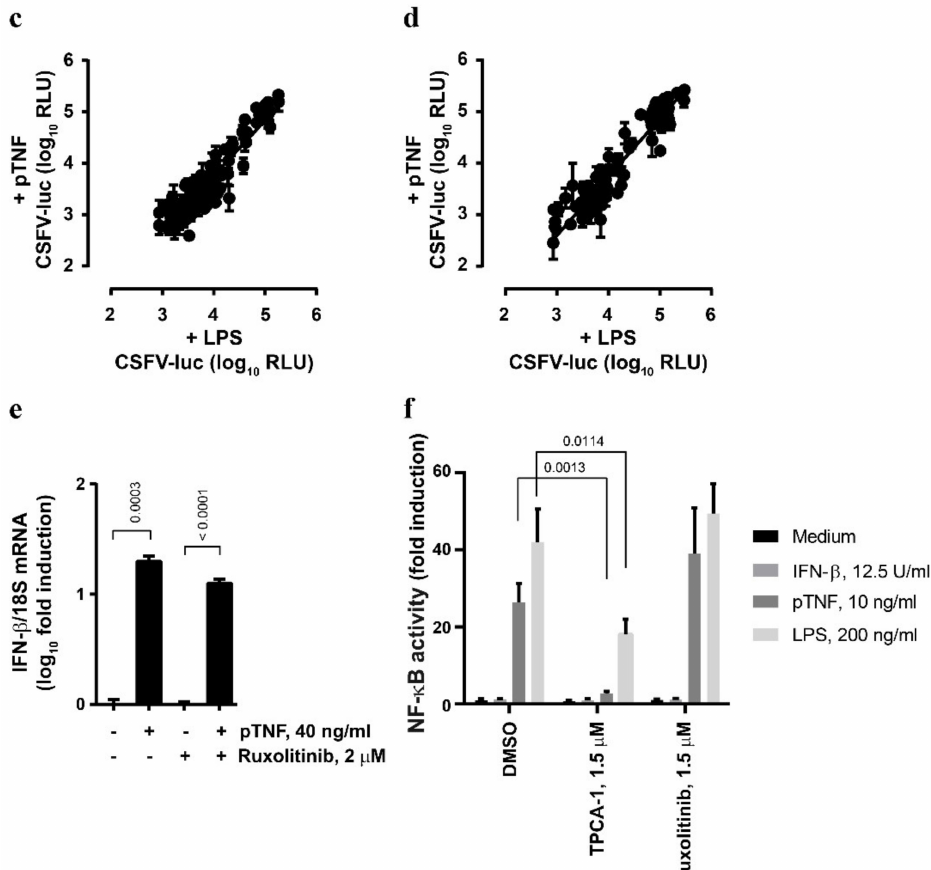
Figure 2. The anti-CSFV activity of TNF involves JAK/STAT signaling. ( a , b ) The PEDSV.15 cells were treated with pTNF ( a ) or IFN- β ( b ) in the presence of ruxolitinib (2 µ M) or DMSO for six hours prior to CSFV-luc infection (MOI, 0.1 TCID 50 /cell) and measurement of firefly luciferase activity 22 h later. The values are shown as the percentage of the DMSO control in the absence of pTNF or IFN- β , respectively. ( c , d ) JAK/STAT inhibitor Compound Library screens were performed with CSFV-luc-infected cells pre-stimulated with the medium, LPS or pTNF in the presence of the individual JAK/STAT inhibitors at the concentration of 0.5 µ M ( c ) or 5 µ M ( d ). The data due to cytotoxic and antiviral activity of the compounds were eliminated from the analysis. ( e ) The PEDSV.15 cells were treated with pTNF or mock in the presence or absence of ruxolitinib for four hours, and the IFN- β mRNA to 18S ribosomal RNA ratio was quantified by means of RT-qPCR and plotted as log 10 fold induction. ( f ) The PEDSV.15 cells were transfected with an NF- κ B-dependent firefly luciferase gene reporter plasmid and treated with IFN- β , pTNF, LPS in the presence of the represented as fold luciferase induction related to the medium treatment. The data represent the means and the standard deviations of three independent experimental replicas. The differences were considered to be statistically significant at p < 0.05 using the Student’s t -test (ns, nonsignificant). Figure 2c,d depicts plotted log 10 RLU values from CSFV-luc-infected cells pre-stimulated with LPS or pTNF in the presence of the individual JAK/STAT inhibitors at concentrations of 0.5 µ M or 5 µ M, respectively. Altogether, we observed a general and strong correla- tion between the capacities of the compounds to interfere with LPS- and pTNF-mediated antiviral signaling without any outliers that would reduce LPS activity without affecting pTNF activity. This suggests that pTNF induces classical antiviral JAK/STAT signaling in PEDSV.15 cells. The effect of selected well-characterized JAK/STAT inhibitors, such as fedratinib, itacitinib, neratinib, pacritinib, tofacitinib, filgotinib, baricitinib and ruxoli- tinib efficiently blocked both LPS- and pTNF-mediated antiviral effects, which is